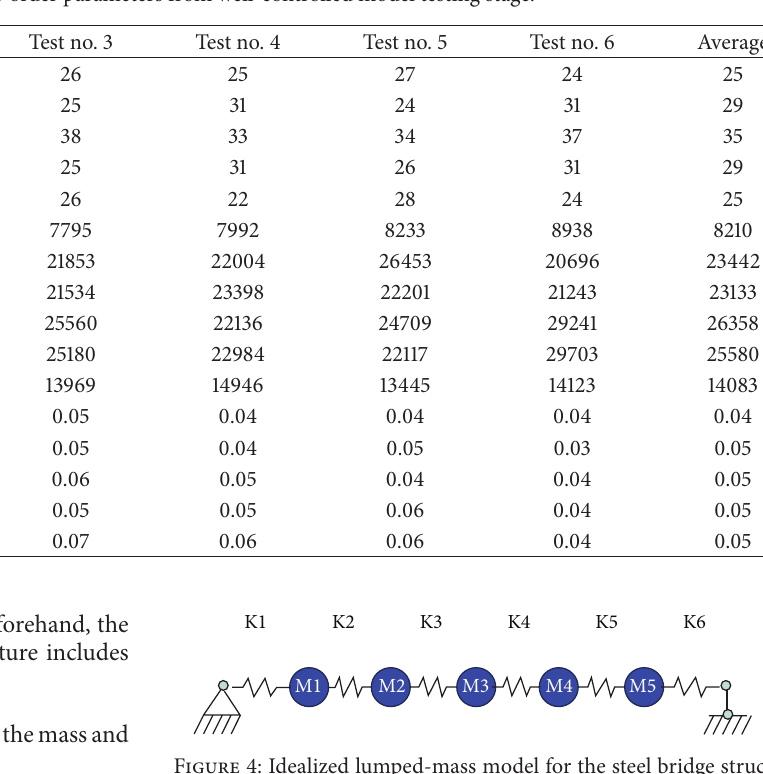
Table 1: Identified second-order parameters from well-controlled model testing stage.